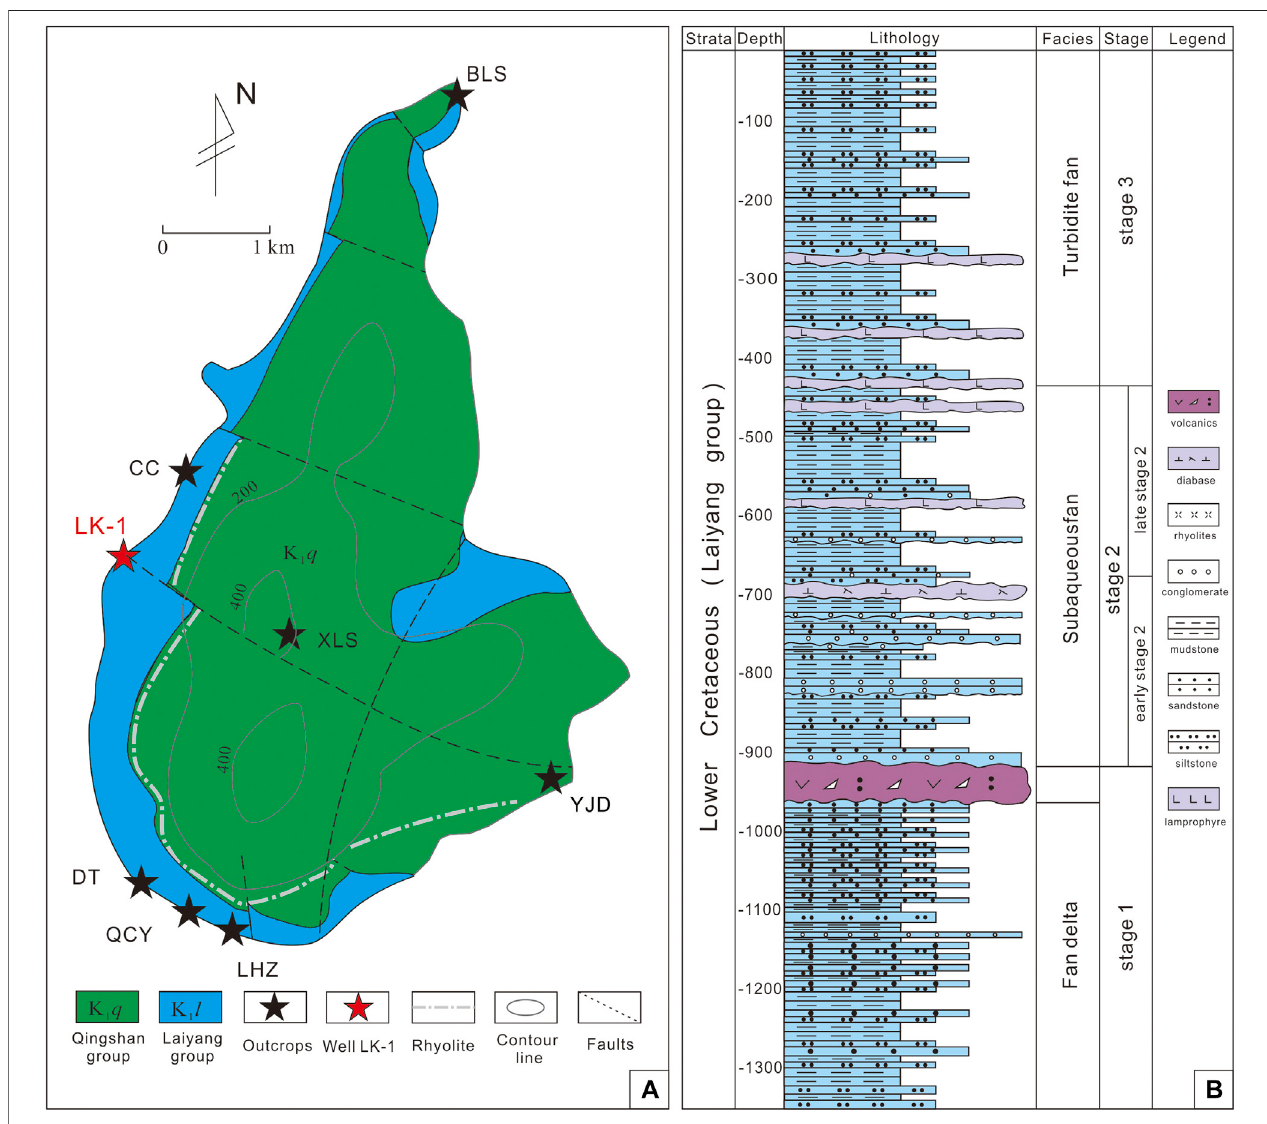
FIGURE 2 | The geological framework and lithology of the well